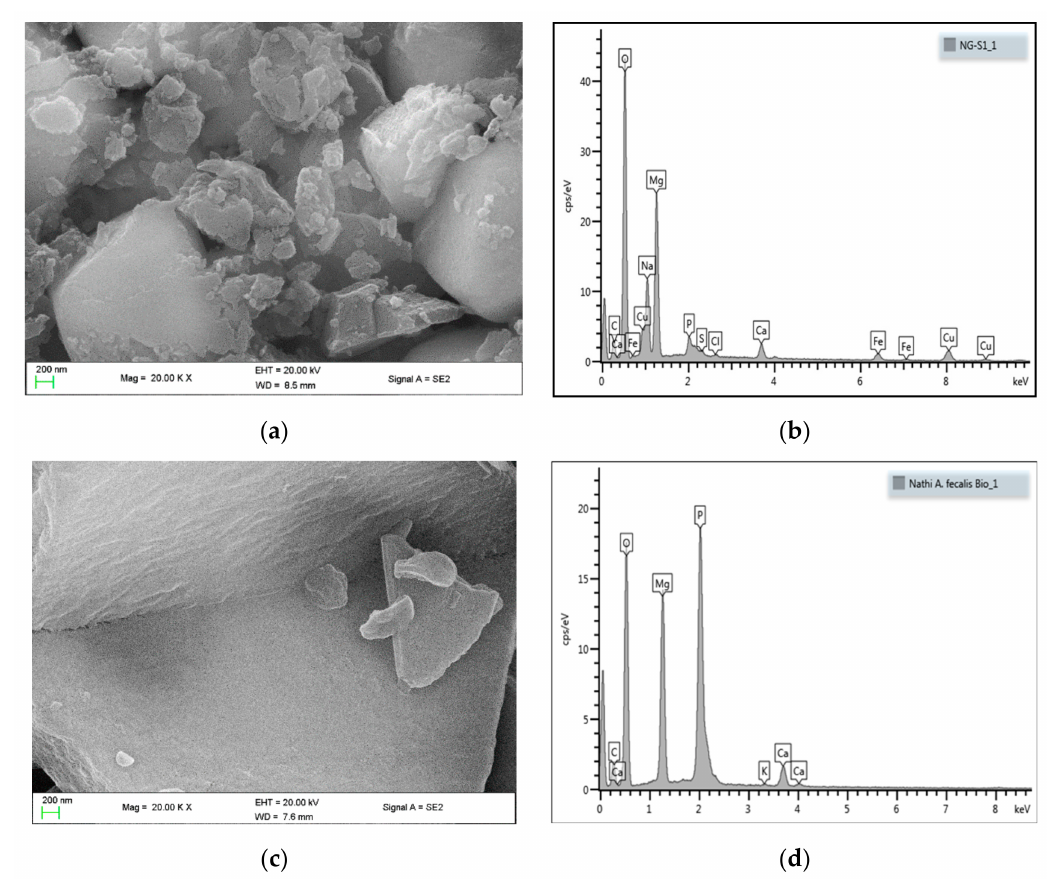
Figure 3. SEM images of ( a ) FeCu BNPs ( b ) corresponding Energy-Dispersive (EDS) spectrum ( c ) bioflocculant and ( d ) corresponding EDS spectrum.